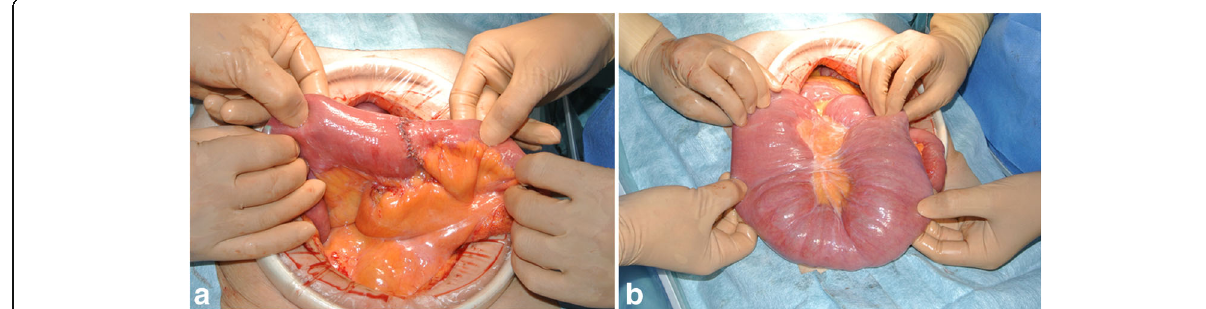
Fig. 6 Intraoperative findings during the second operation. a The jejunoileal anastomosis was not stenotic. b The proximal small bowel was markedly